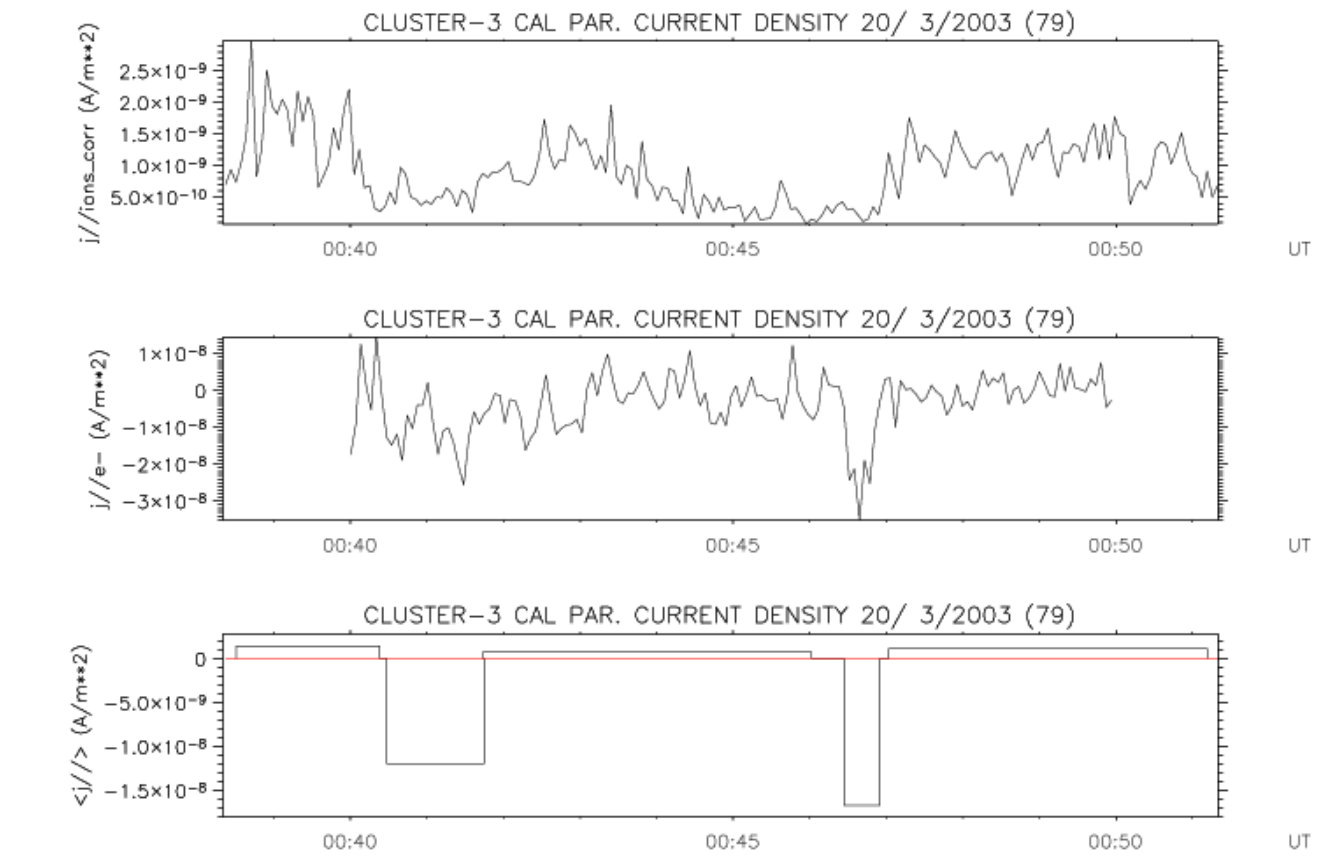
Fig. 12. Component of the current density j // along the magnetic field carried by the ions (top panel) and electrons (second panel), for 20 March 2003 between 00:38:20 and 00:51:20 UT and total parallel current density averaged over each structure (bottom